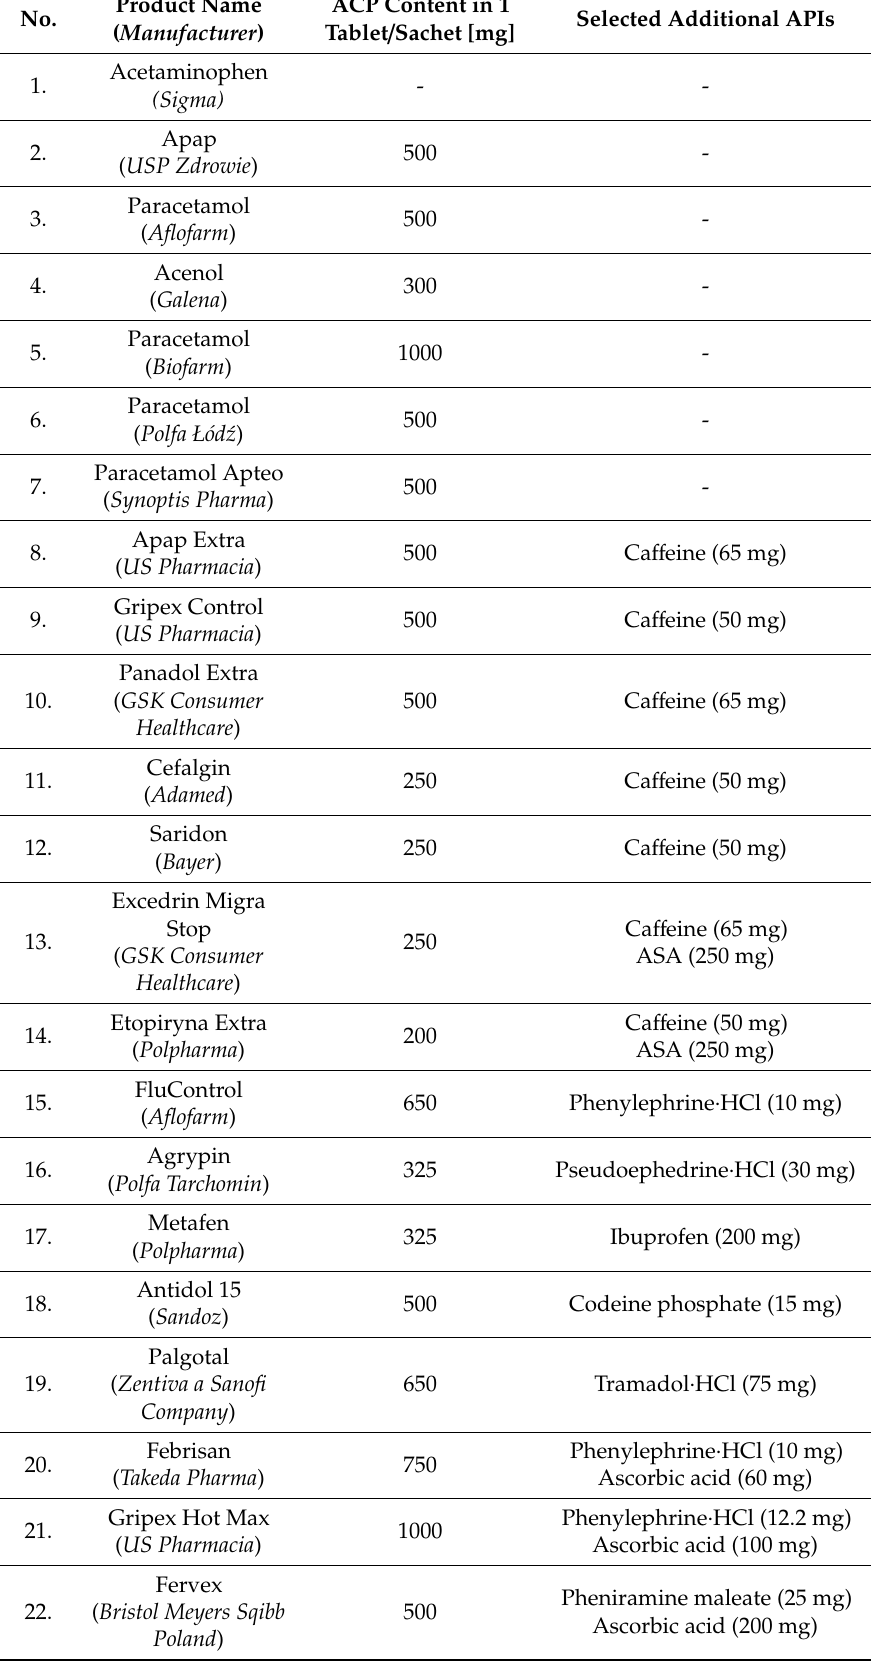
Table 7. Analysed drugs containing ACP and pure ACP as a chemical